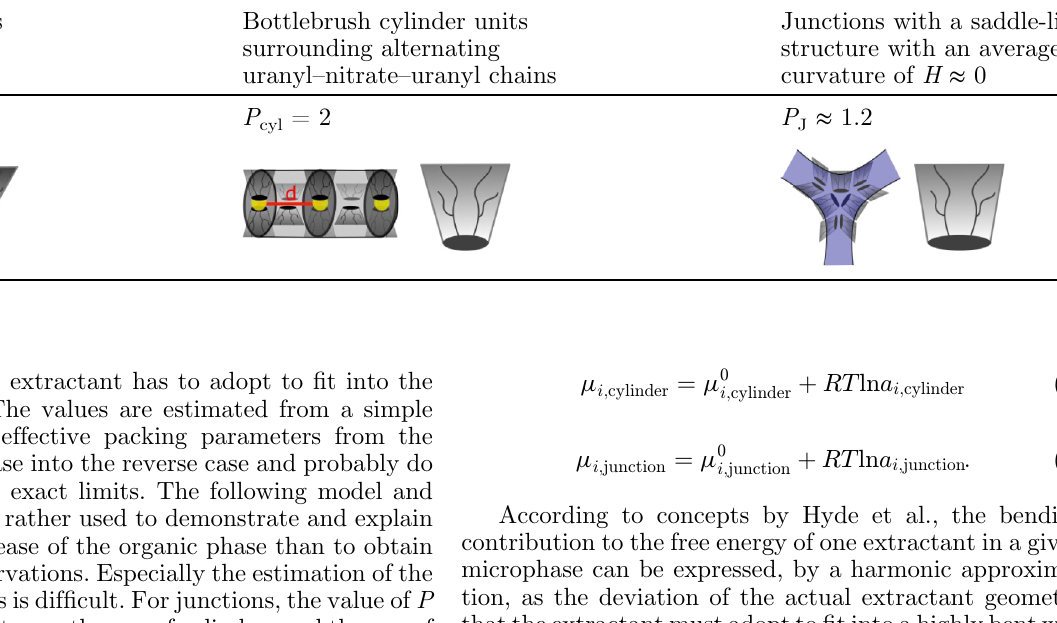
Table 1. The three microphases in chemical equilibrium. Spherical